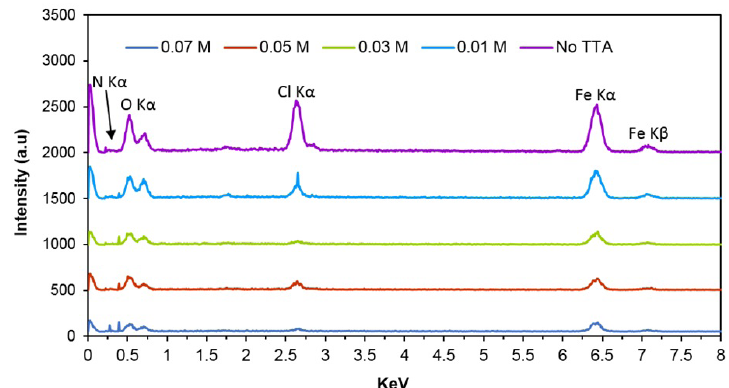
Figure 11. EDS spectra of mild steel surfaces in the a) absence and in the presence of b) 0.01 M, c) 0.03 M, d) 0.05 M and e) 0.07 M TTA exposed to 0.5 M HCl for 2 h.